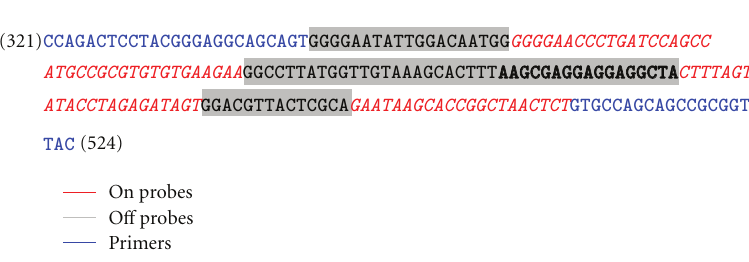
Figure 1: On/O ff Probe placement for the 321–524 bp region of the 16S rDNA gene of A. baumannii (NC 010400). The On probes are in red text italics and O ff probes highlighted in grey. The primers are in blue text. Distinctions between two adjacent probes are in bold. Table 3: LATE-PCR 16S sepsis multiplex primer and probe